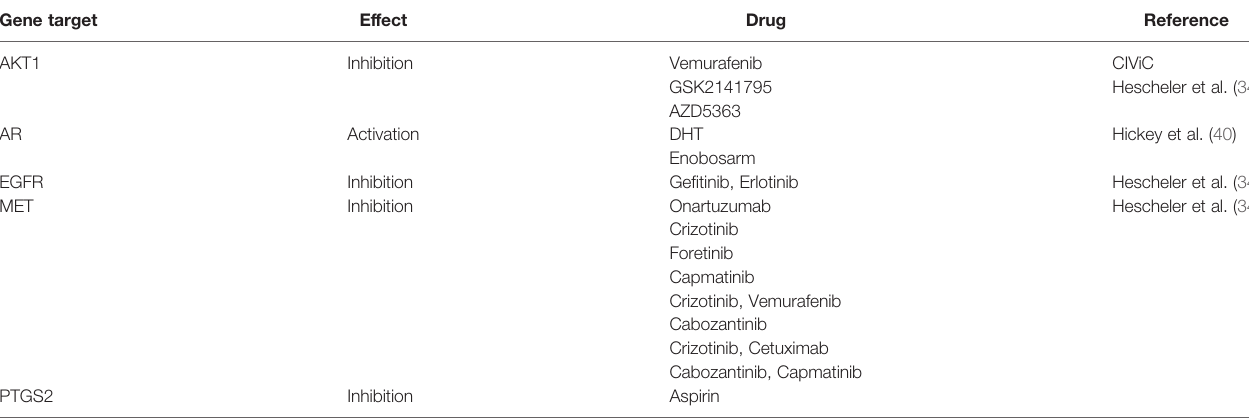
TABLE 2 | FDA-approved drugs targeted for lung metastasis-related